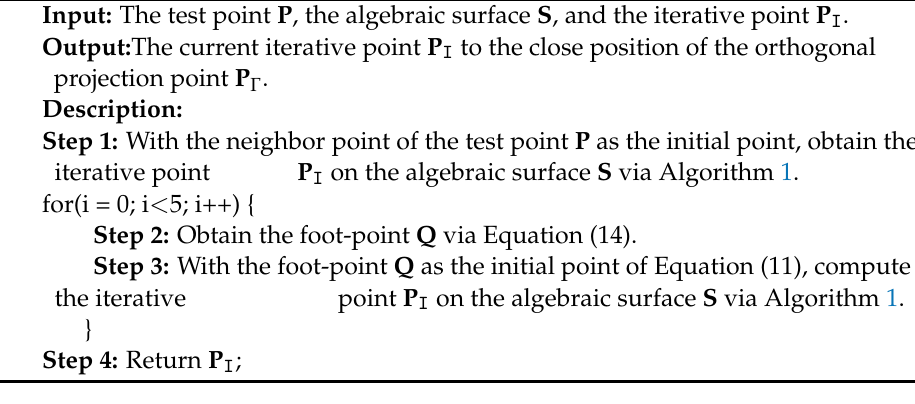
Algorithm 2: Computing the foot-point Q and moving the iterative point P I to the close position of the orthogonal projection point P Γ .